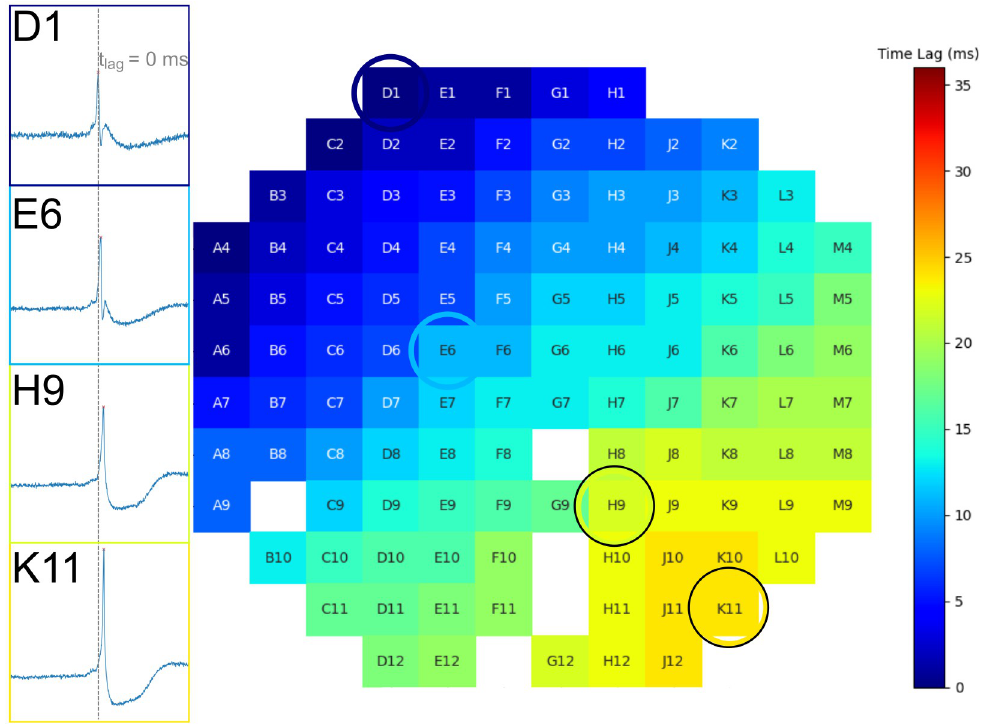
Fig 2. Field potentials of electrodes in four different regions of the pacemaker map. The pacemaker region is near electrode D1, which has a recorded normalized time lag of t lag = 0 ms. Electrodes further from the pacemaker exhibit a shift to the right of the t lag = 0 ms time point (dashed, vertical line) and show how the time at which the signal is detected increases with increasing distance away from the pacemaker region. This shift is correlated with the heatmap time lag values. White squares indicate electrodes that were excluded from analysis due to insufficient